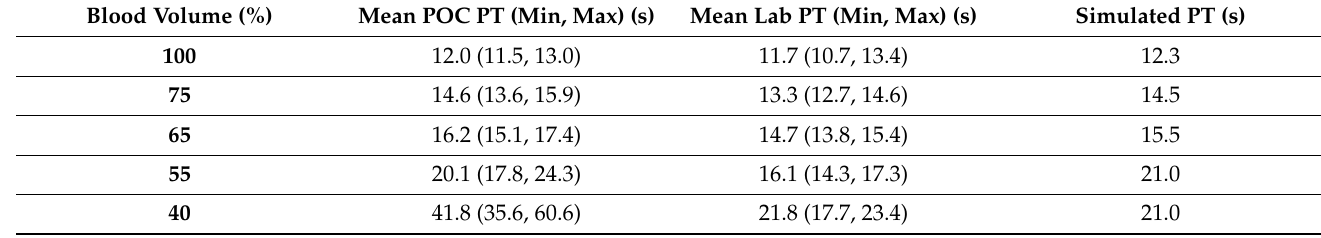
Table 1. Comparison between point of care prothrombin time POC PT [30] and simulated PT.